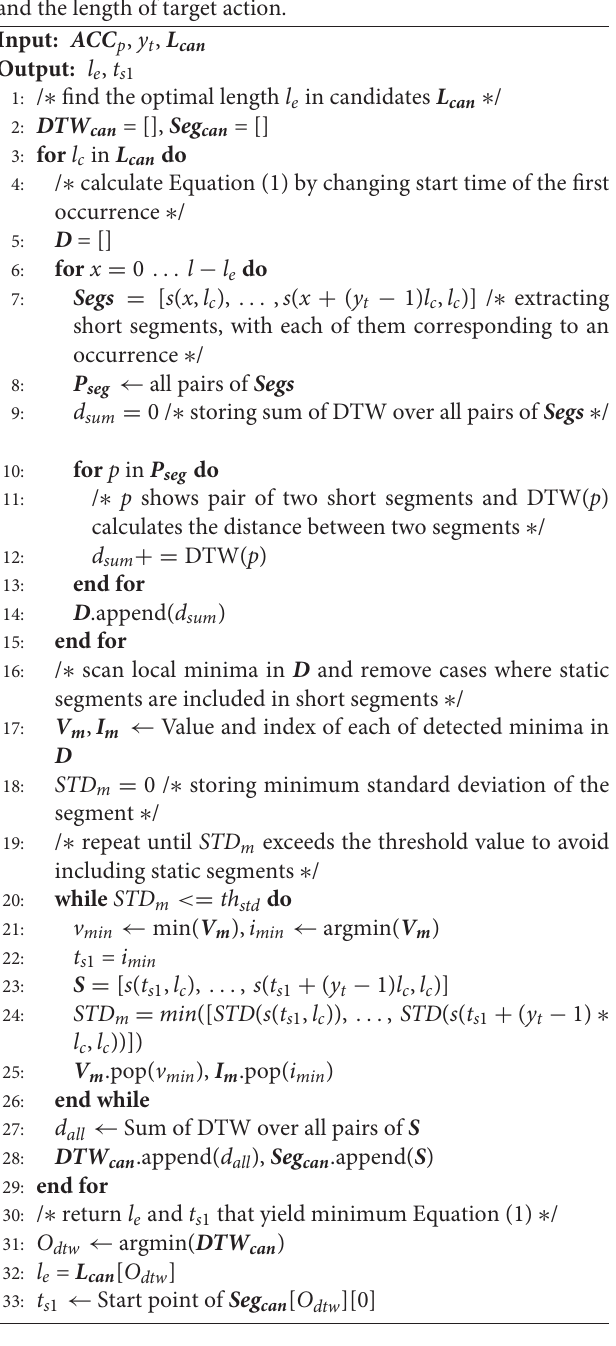
TABLE 1 | Parameters used in the methods and